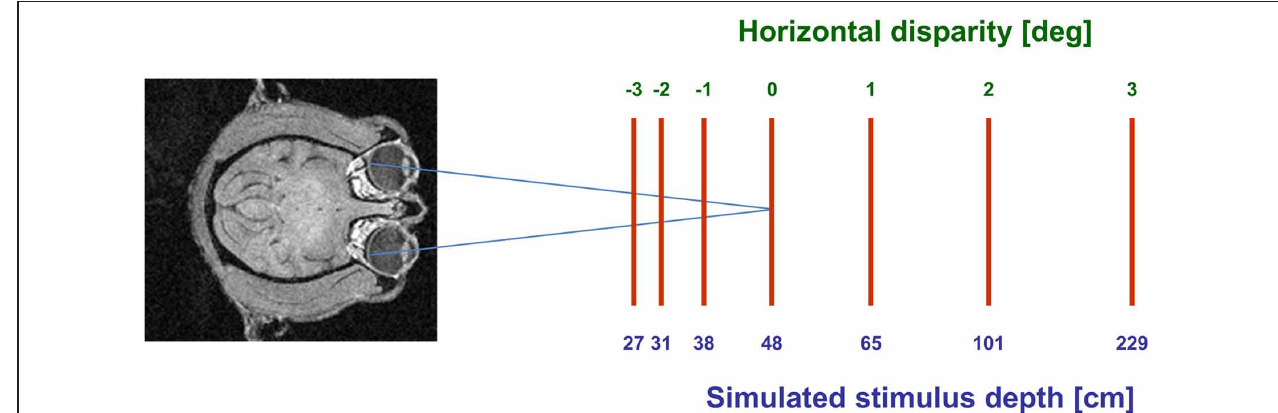
negative values) to 3 ◦ uncrossed disparity (far space; positive values). These disparity values corresponded to simulated depths ranging from 27cm to 229cm in front of the